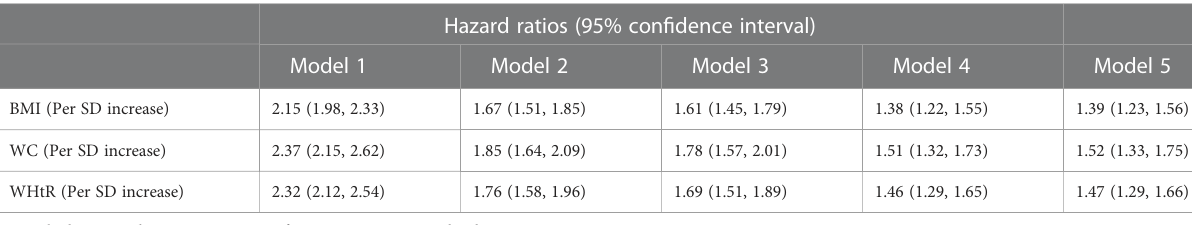
TABLE 2 Cox regression analyses for the association between BMI, WC, WHtR and incident diabetes in different models.